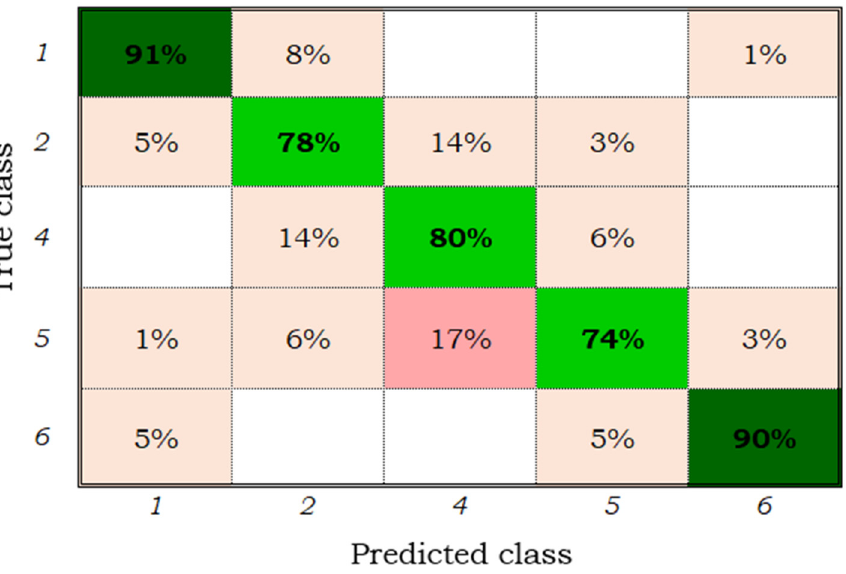
Figure 7. Confusion matrix of the quadratic SVM model for five classes and 45